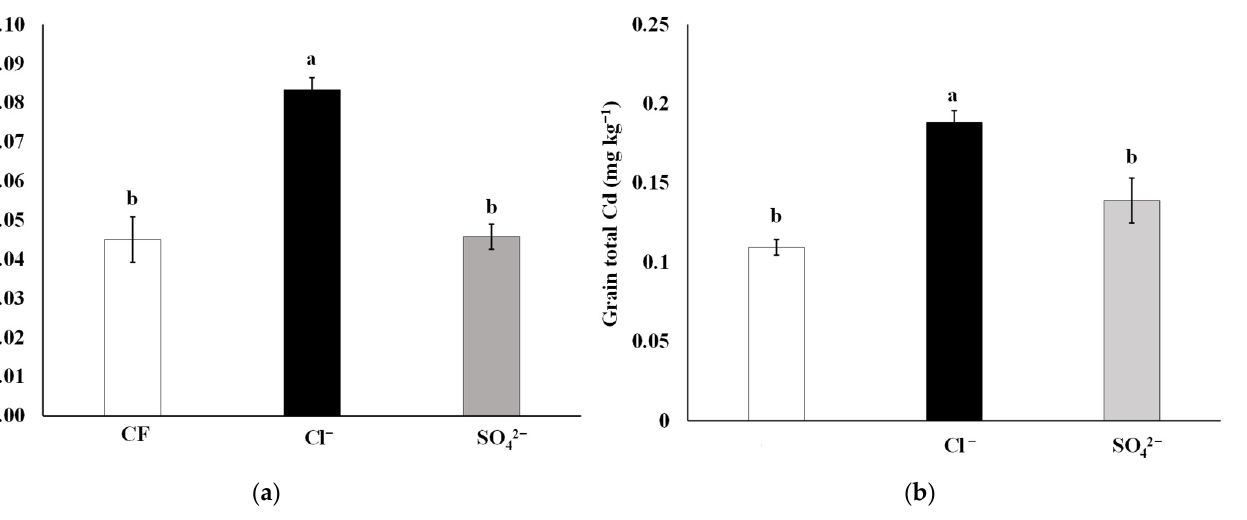
Figure 2. Effects of long-term field Cl − and SO 42 − fertilizer applications on ( a ) EDTA extractable Cd in the soil and ( b ) Cd concentrations in the rice grains. Vertical bars represent the standard deviation ( n = 3). Different lower-case letters indicate significant differences at p < 0.05 according to Duncan’s test.